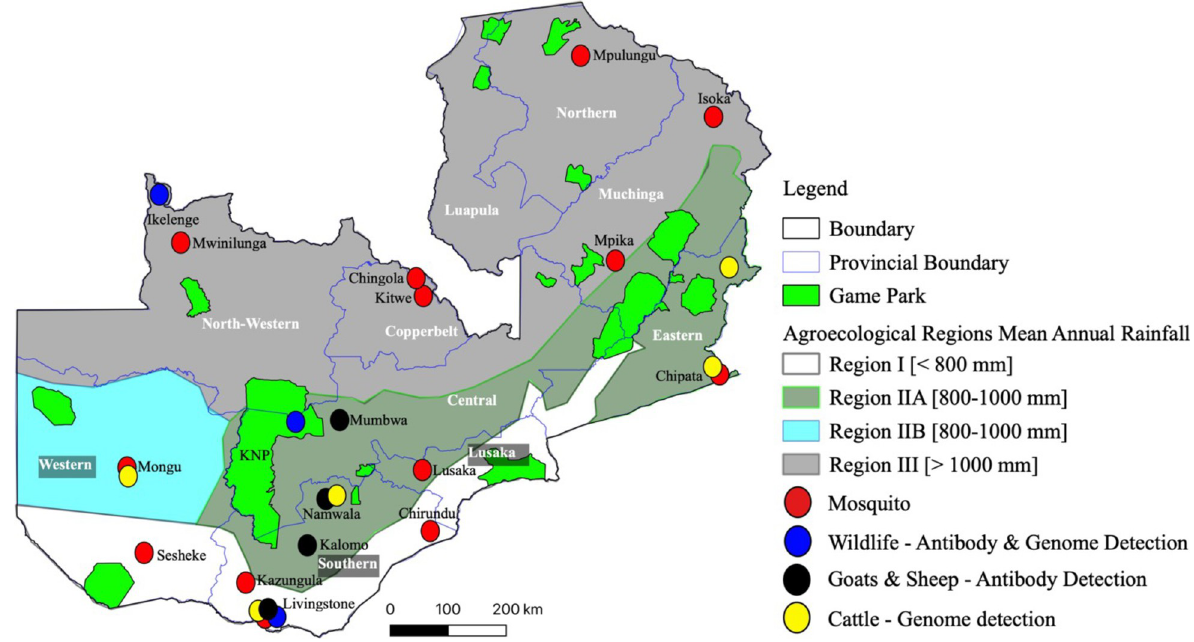
Fig 1. Agroecological regions and location of sample collection areas by district. Shapefile republished from DIVA-GIS database (https://www. diva-gis.org/) under a CC BY license of Global Administrative Areas (GADM), copyright 2018.